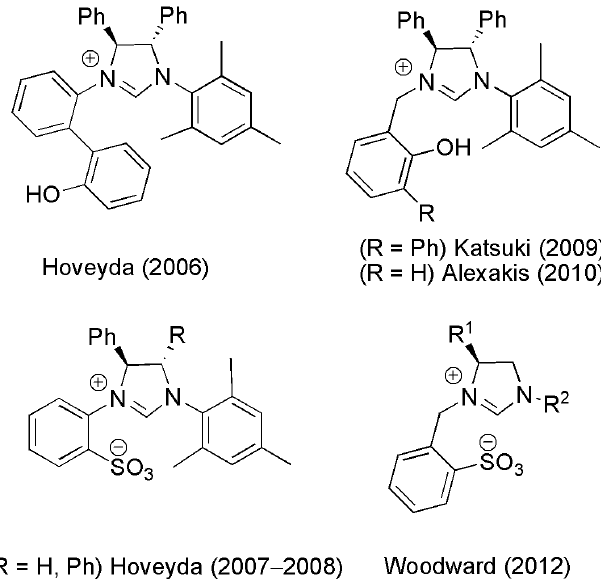
Figure 15. Azolium salts containing a chiral moiety [97].